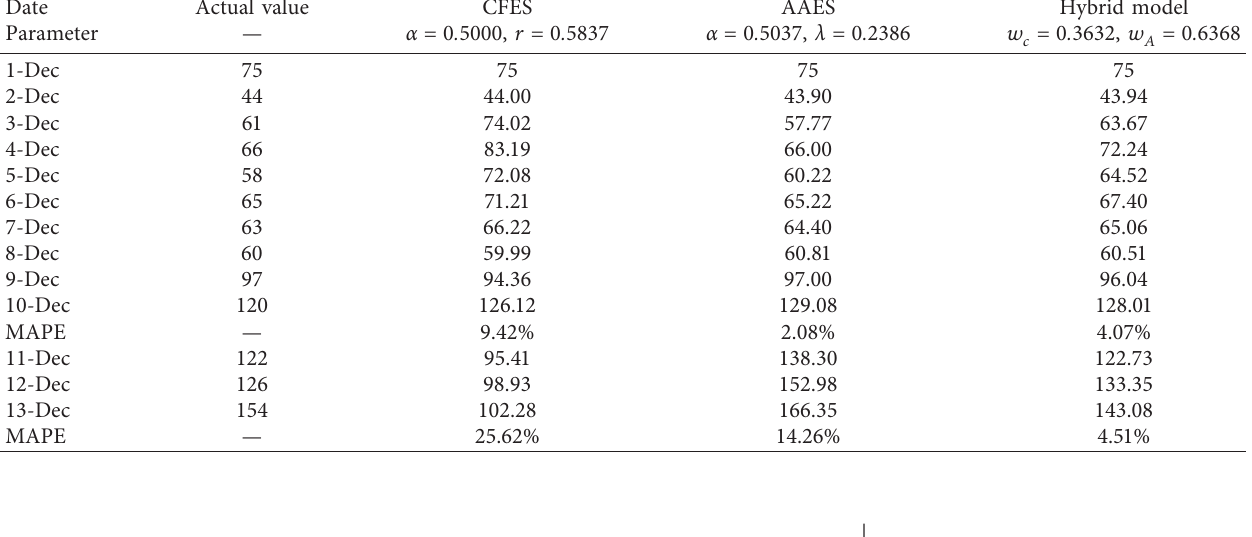
Table 7: The forecasting results of PM